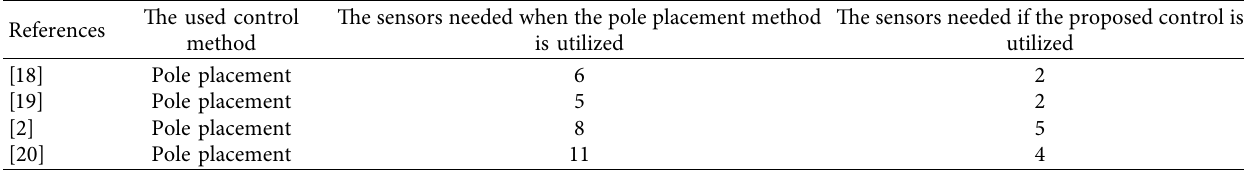
Table 1: Superiority of the proposed control method compared to the pole placement technique.